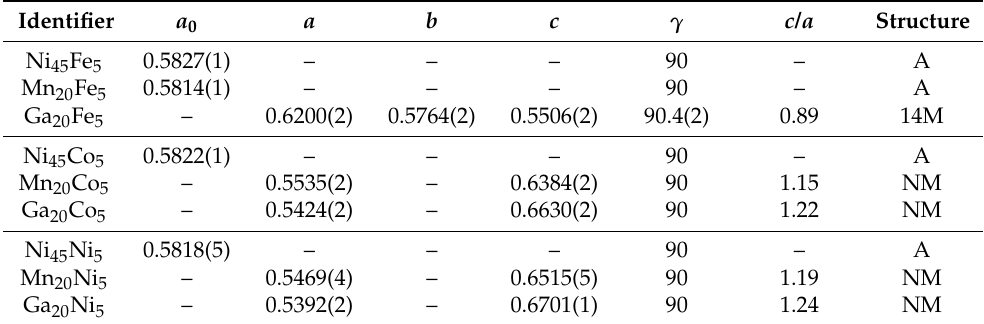
Table 2. Structure and lattice parameters (nm) were determined at room temperature by X-ray diffraction. XRD patterns for all compositions are shown in the Supplemental File.